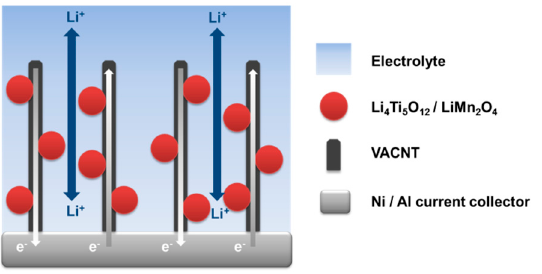
Figure 1. Schematic concept of vertically aligned carbon nanotubes (VACNT)-based Li 4 Ti 5 O 12 (LTO) and LiMn 2 O 4 (LMO) nanoarrays.